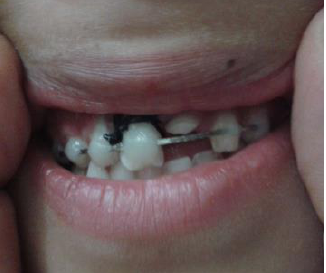
Figure 2: Replacement of twisted wire with a braided retainer